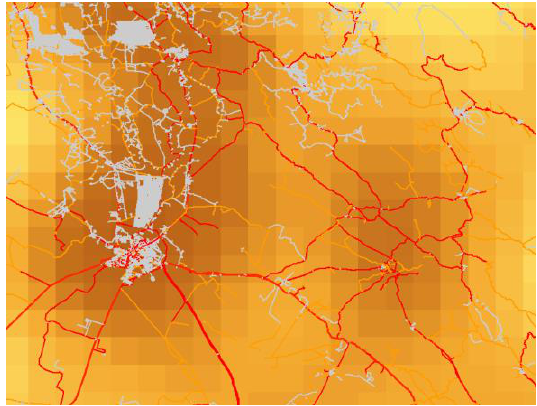
Figure 10. More lines lead to too high value The red lines are primary road and light grey lines are low- grade traffic lines. The density of high-grade traffic lines of